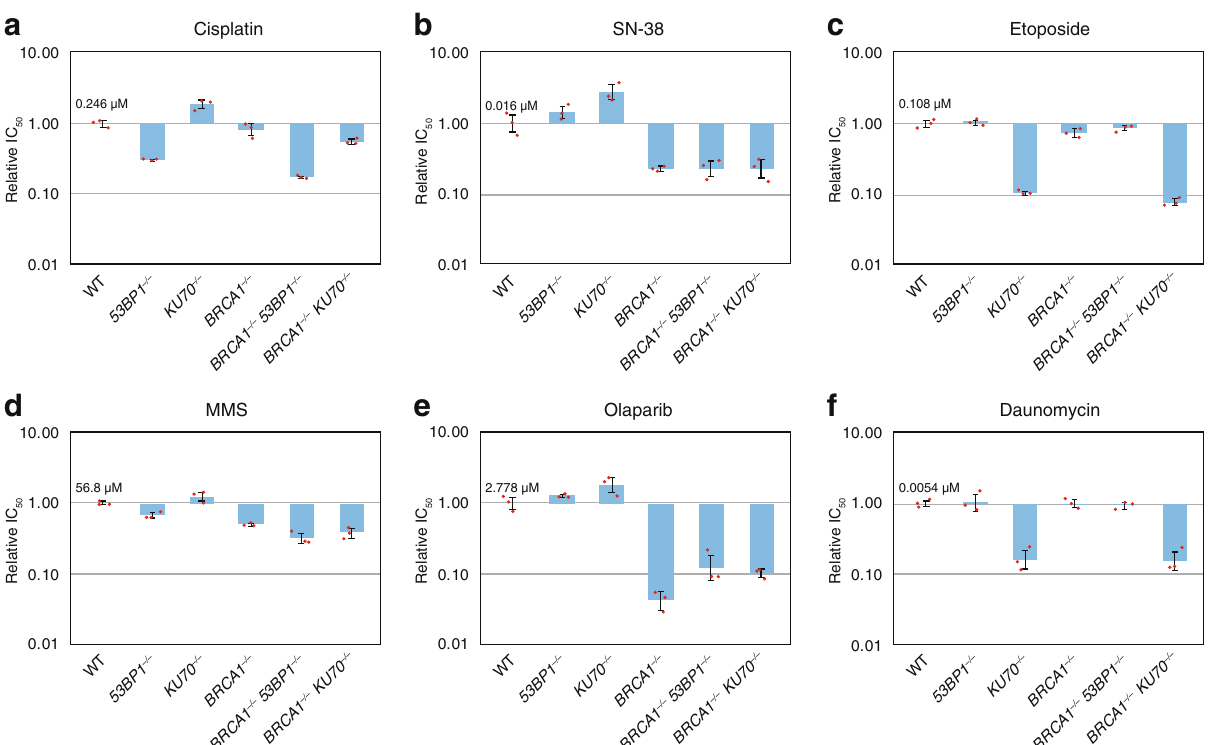
Fig. 5 Interaction of BRCA1 and 53BP1 in the tolerance to cytotoxic agents. a – f Cytotoxicity measurements on DT40 cell lines of the indicated genotypes using drugs named above each panel. Results are shown as mean and SEM of relative IC 50 concentrations compared to the WT cell lines, individual values derived from n = 3 independent experiments are indicated. The mean IC 50 value of the WT cell line is displayed on each panel. Source data are provided as a Source Data fi